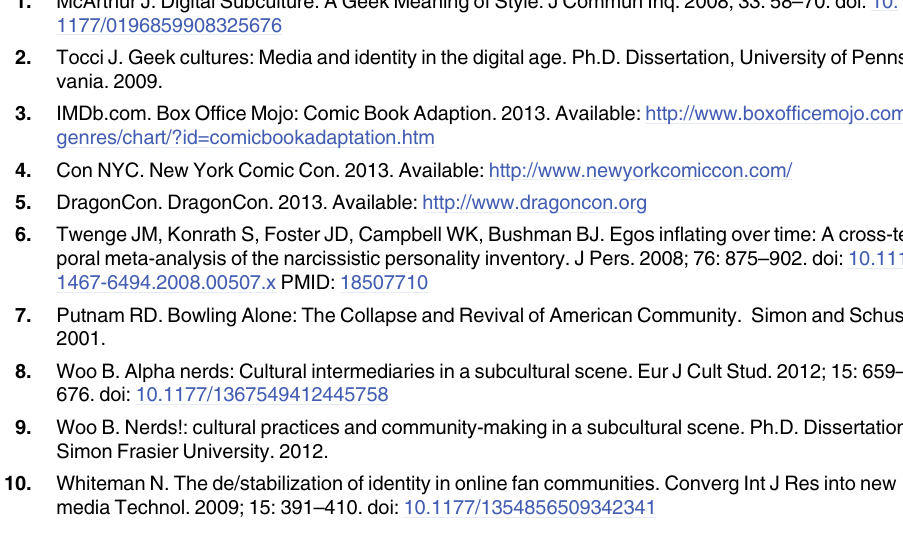
Scoring: No items are reverse scored. The full scale is calculated by calculating the mean of all